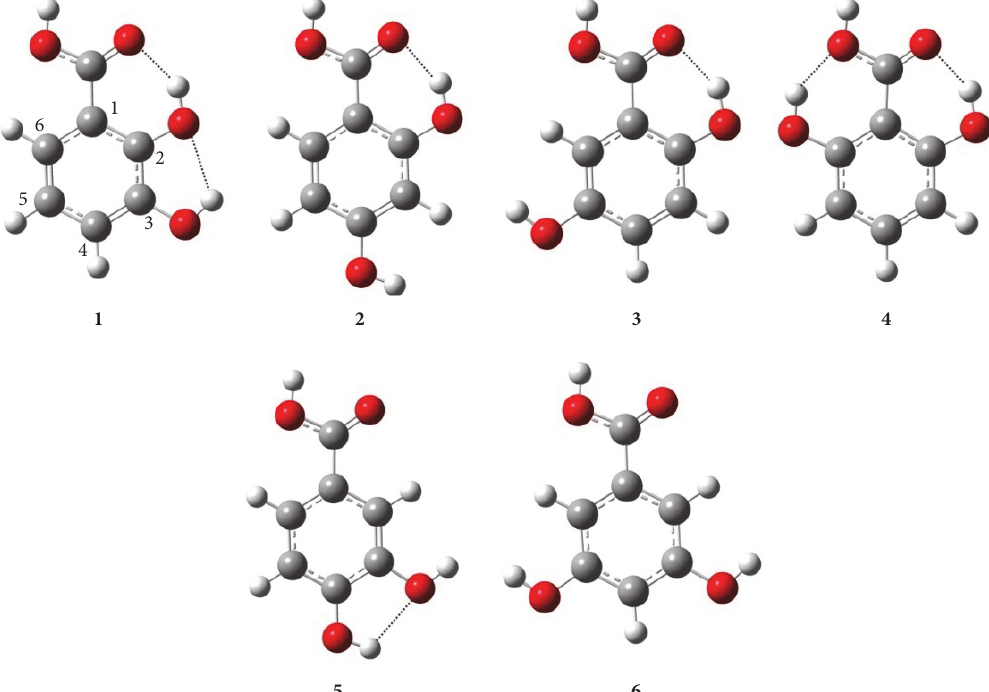
Figure 2: The most stable structures of the examined